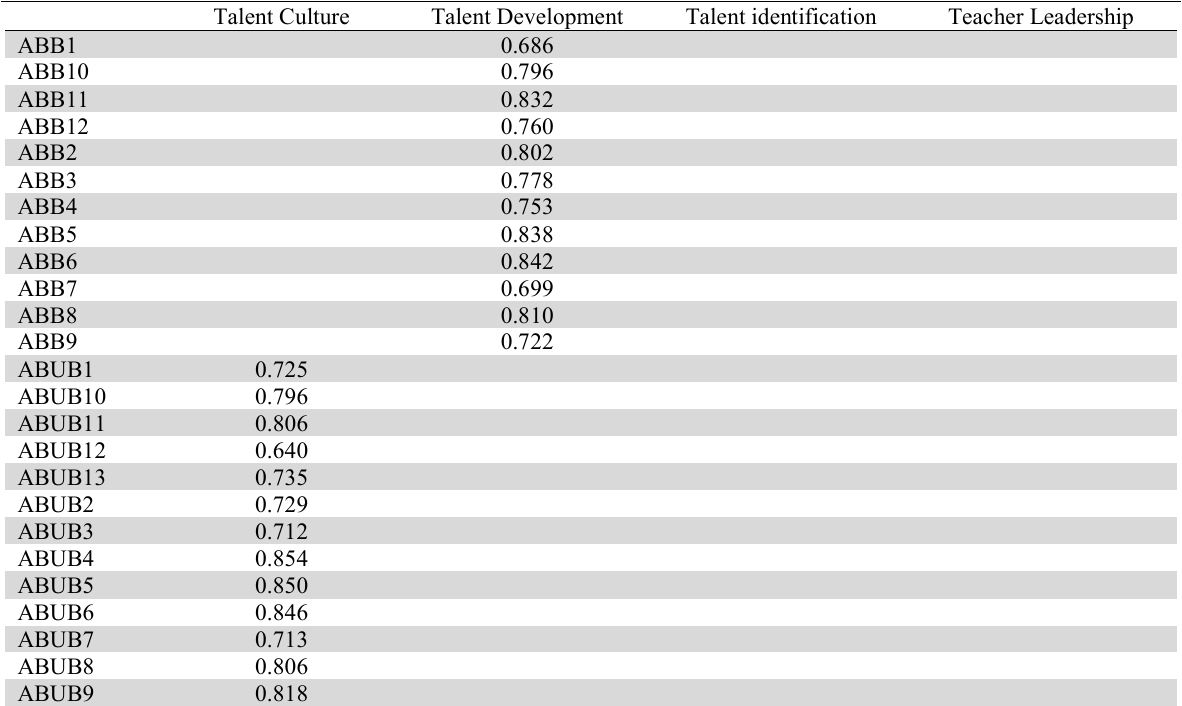
Loading factors